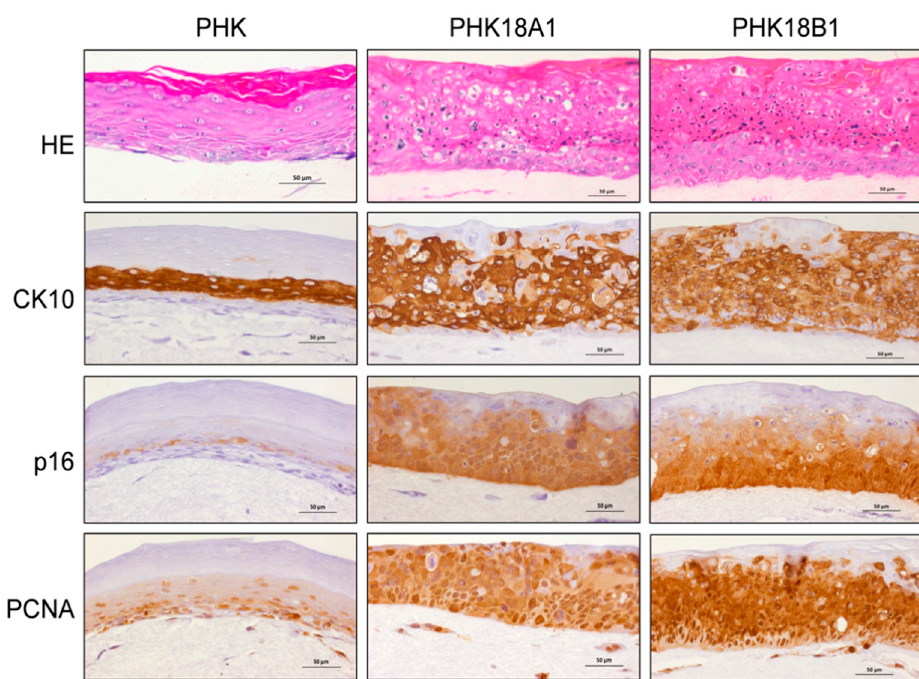
Figure 6. Organotypic cultures obtained from immortalized PHK18A1 and PHK18B1. Shown are representative micrographs of HE stained tissues, in addition to IHQ to assess the levels of CK10, p16, and PCNA. Figures derived from a representative of two independent assays performed.